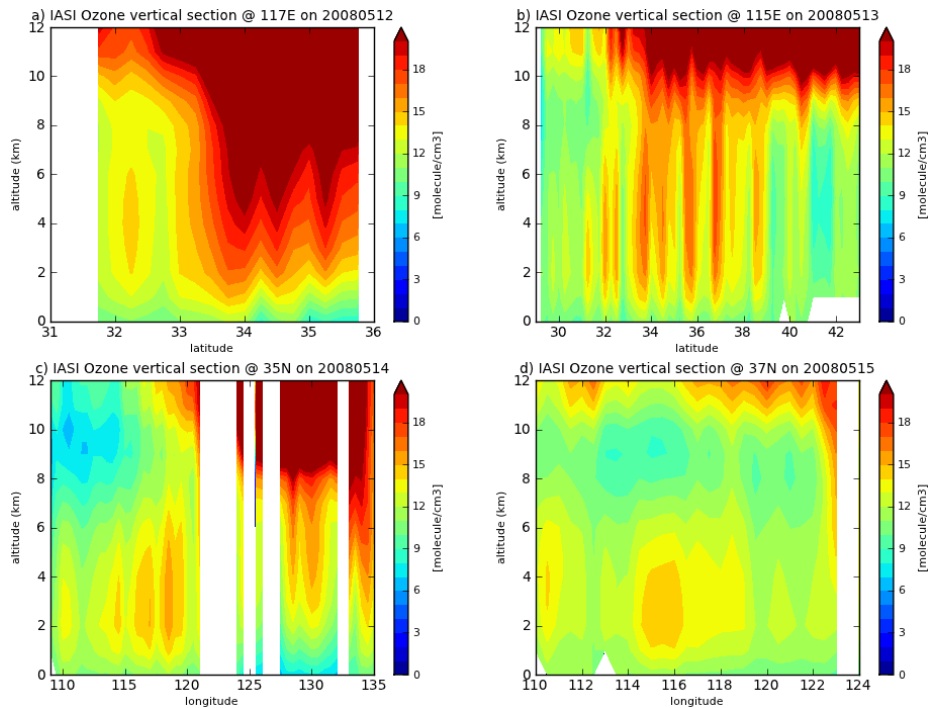
Figure 7. Vertical section of ozone concentration (in moleculecm − 3 ) retrieved from IASI along specific longitudes – (a) 117 ◦ E on 12 May 2008, (b) 115 ◦ E on 13 May 2008 – and along specific latitudes – (c) 35 ◦ N on 14 May 2008, (d) 37 ◦ N on 15 May 2008. The longitudinal (latitudinal) sections are computed over 1 ◦ around the specific longitude (latitude) with a 0.25 ◦ resolution in latitude (longitude).